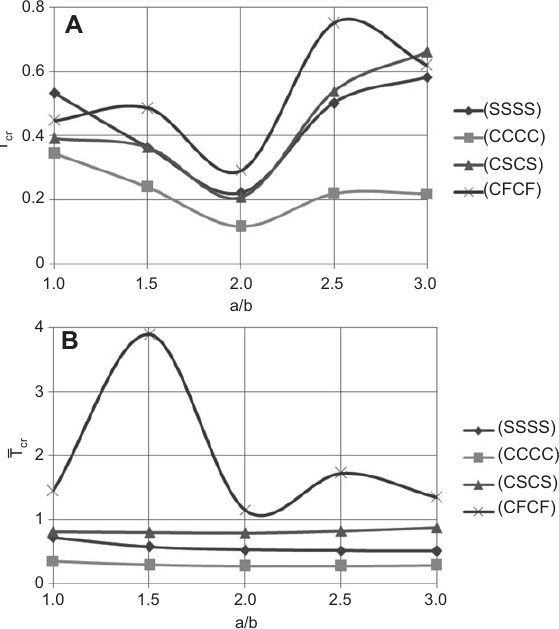
Figure 2 Effects of plate aspect ratios and boundary conditions on critical thermal buckling